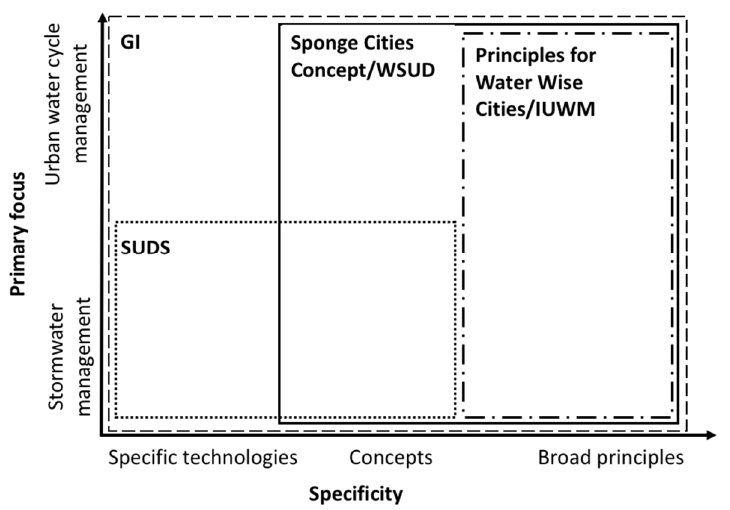
Figure 1. A classification of terminology related to the domain of integrated urban water management (IUWM) according to the terms’ specificity and their primary focus (modified from [24]). GI, green infrastructure; SUDS, sustainable urban drainage systems; WSUD, water-sensitive urban design.